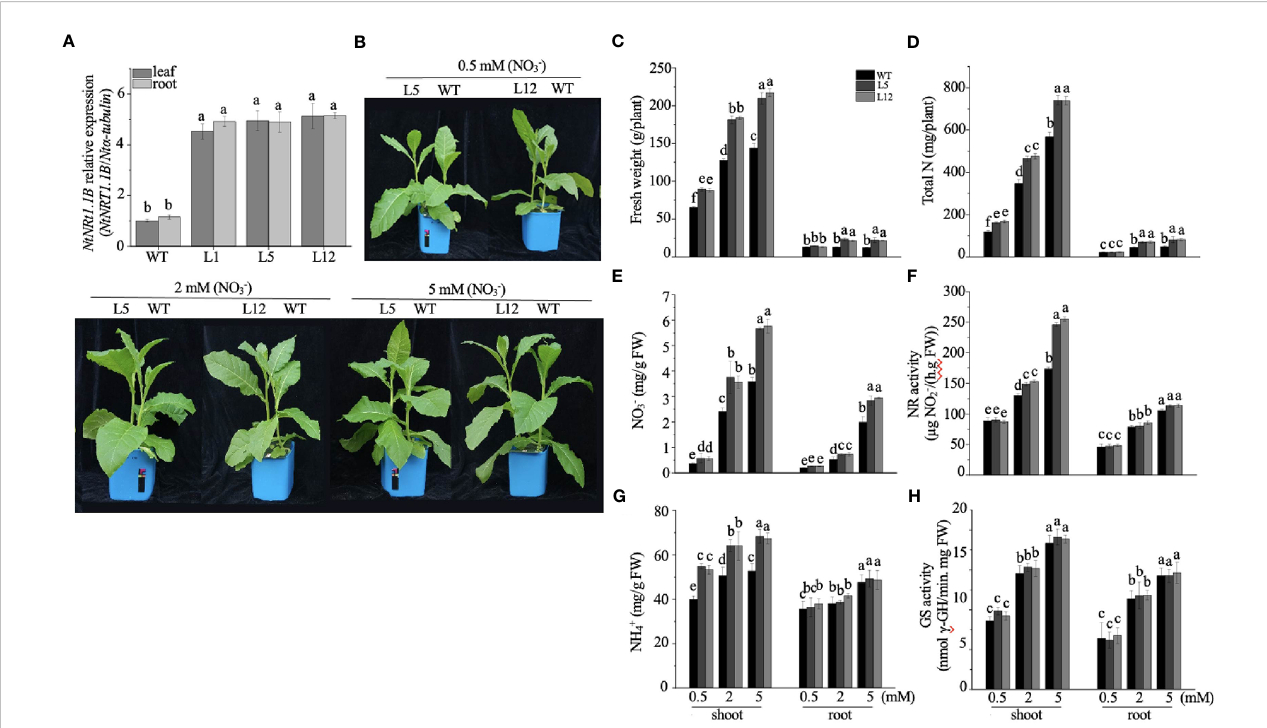
FIGURE 5 Overexpression of NtNRT1.1B signi fi cantly enhances the growth of tobacco plants. NtNRT1.1B -transformed tobacco lines and their WT (K326) plants were hydroponically cultured for 25 days with a supply of NO − 3 as the sole N source at a concentration of 0.5, 2, or 5 mM (see Materials and methods). For the measurement of N-related physiological components (see Materials and methods), the second and third fully expanded leaves counted down from the top were sampled; four biological replicates were conducted. (A) Detection of NtNRT1.1B transcript abundance. Roots and shoots of three independent NtNRT1.1B -overexpressing lines (L1, L5, and L12) and WT grown on 1/2 Murashige & Skoog (MS) agar plates for 14 days were sampled for gene expression by using qPCR (see Materials and methods). The expression level of NtNRT1.1B relative to that of a -tubulin (set to 1) was calculated and plotted. Data were obtained from four biological replicates. (B) Images of representative growth phenotype of NtNRT1.1B -overexpressing lines and WT tobacco grown with NO − 3 as the sole N source. Plant culture is as described above. (C – H) Quanti fi cation of the fresh weight of shoots and roots (C) , total N (D) , the content of NO − 3 (E) and NH + 4 (G) , and enzymatic activity of glutamine synthetase GS (F) and nitrate reductase NR (H) . Means ± standard deviation (SD) ( n = 4) are depicted, and different letters indicate statistically signi fi cant differences [ P < 0.05, one-way analysis of variance (ANOVA)]. Similar results were obtained from experiments with plants cultured under in pots with soil growth conditions (see Supplemental Figure